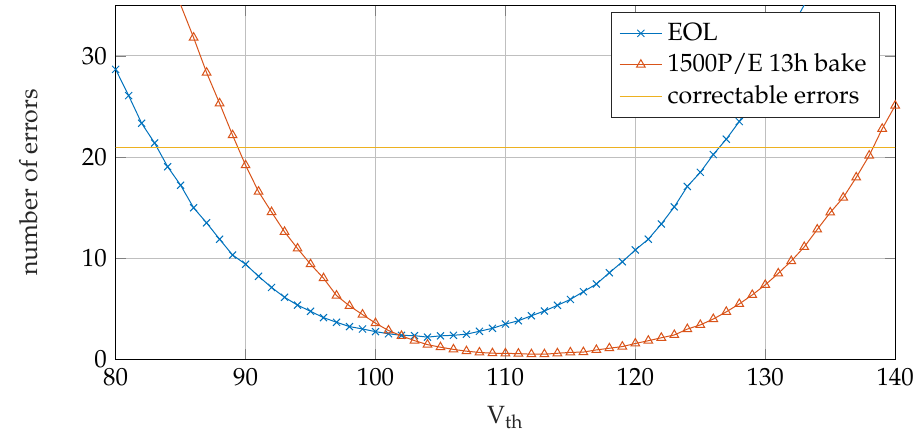
Figure 6. Number of errors in the meta-data over threshold voltage.